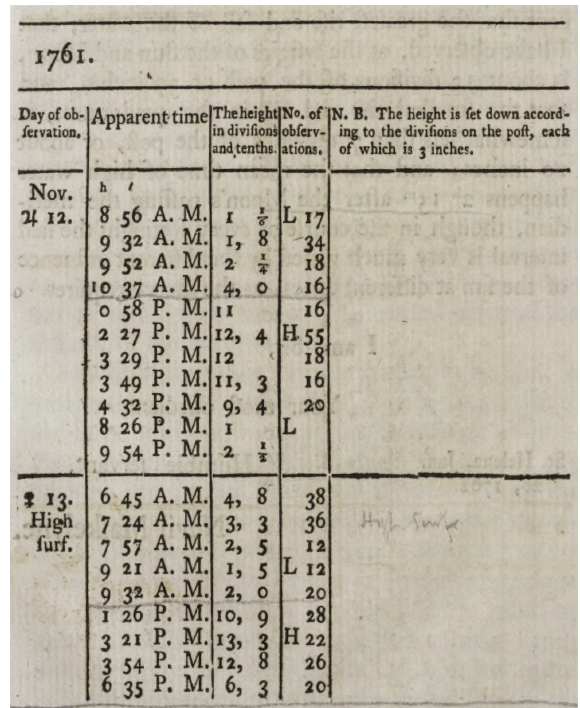
Figure 1. The start of the table of measurements of sea level at St. Helena in 1761 to be found at the end of Maskelyne (1762).